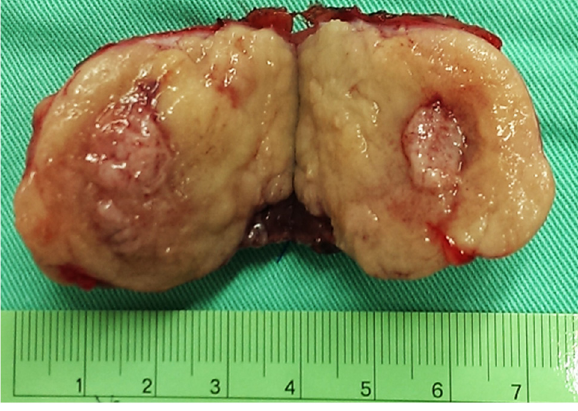
Figure 2: The specimen of the main renal tumor.